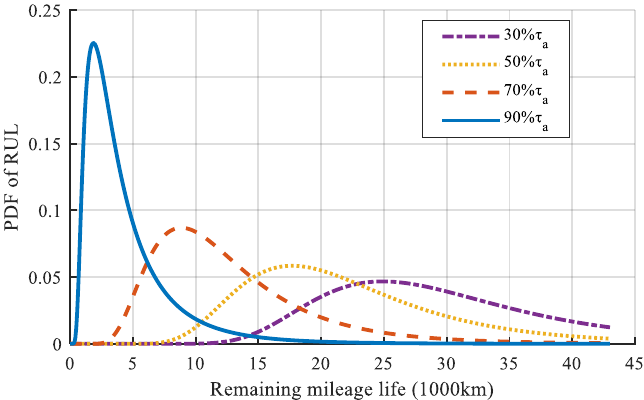
Figure 12. The PDF of the RUL prediction at life quantiles.